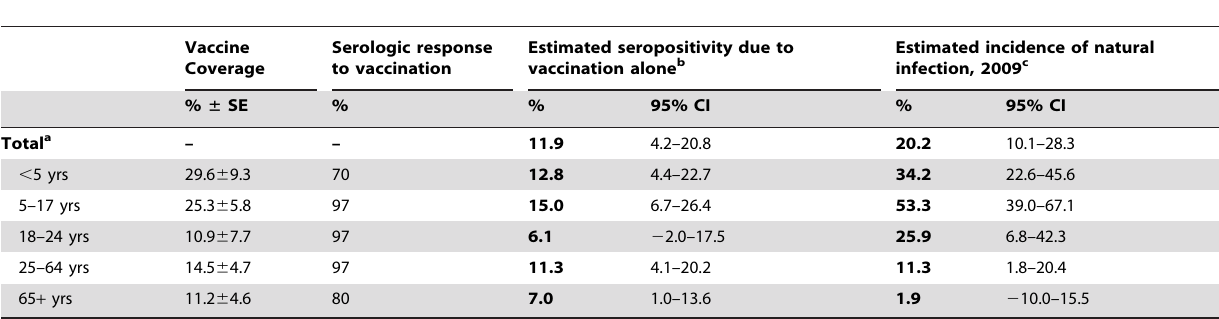
Table 2. Vaccination and adjusted estimates of the increase in seropositivity from baseline to December 2009 due to natural infection with A(H1N1)